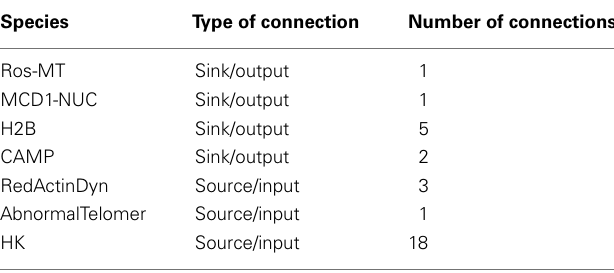
Tablecontainsspecieswithoutsuccessor(therearenoedgescomingoutofthese nodes) and predecessor (there are no edges going to these